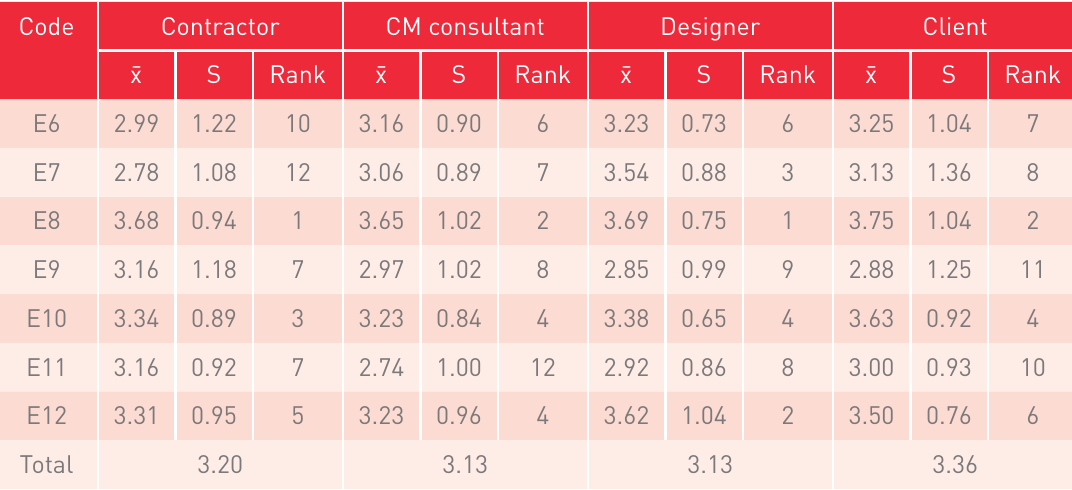
Table 12. Code Contractor Designer Client